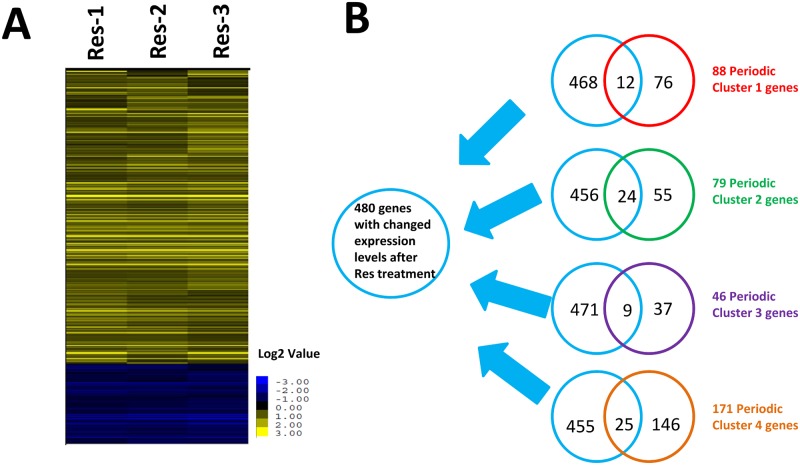
Resveratrol significantly changes the transcription levels of periodic expressed genes.(A) Clustering analysis based on the microarray analysis in which the data were selected by both the Fold Change (>50%) and p-value (<0.05). R-1, R-2, and R-3 represent three biological replicates. The blue color depicts the genes with decreased expression levels, and the yellow color depicts genes with increased expression levels. (B) The overlapping analysis between resveratrol-changed genes and previously reported periodic gene expression changes (the gene lists were adapted from Rustici et al.[19]). Cluster 1, 2, 3, and 4 with differently colors represent the gene list with different expression rhythms. In detail, the blue circle represents the 480 genes with changed expression level after resveratrol treatment; the red circle represents the previous published 88 Cluster 1 periodic genes; the green circle represents the previous published 79 Cluster 2 periodic genes; the purple circle represents the previous published 46 Cluster 3 periodic genes; the brown circle represents the previous published 171 Cluster 4 periodic genes.